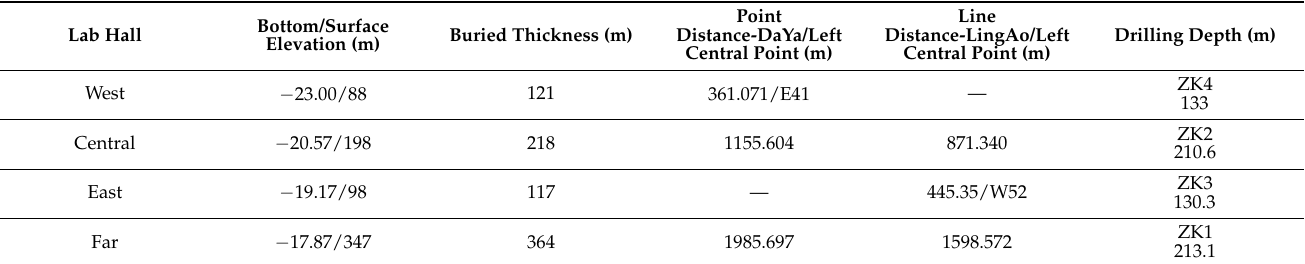
Table 3. Location of observation laboratory halls and boreholes at the DBNL